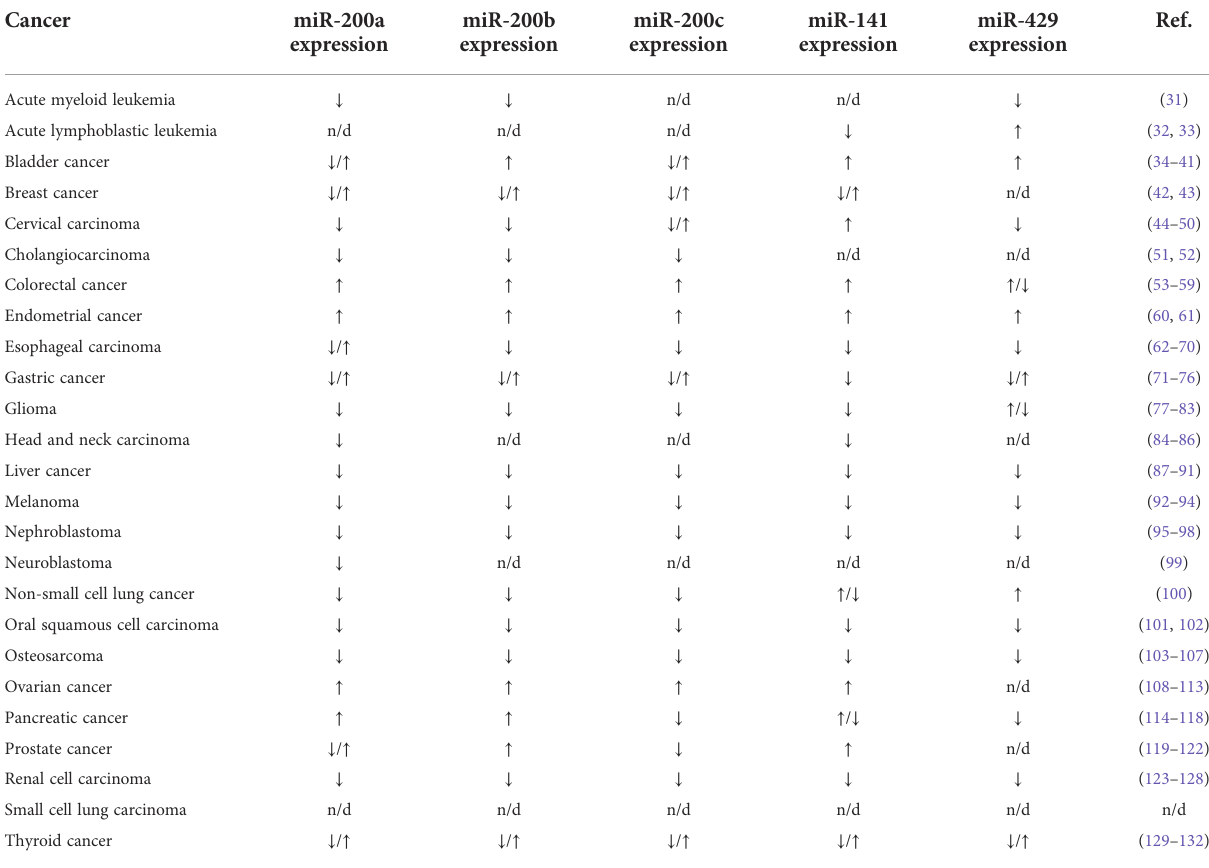
TABLE 1 The expression of miR-200 family members in different types of cancer compared to the healthy